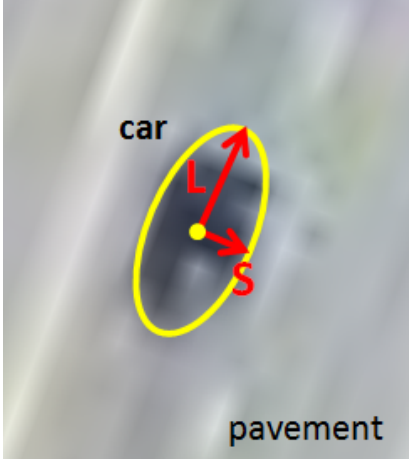
Figure 9: Vehicle shape saliency.Vehicle is marked with yellow border and long and short axis of the ellipse are marked with